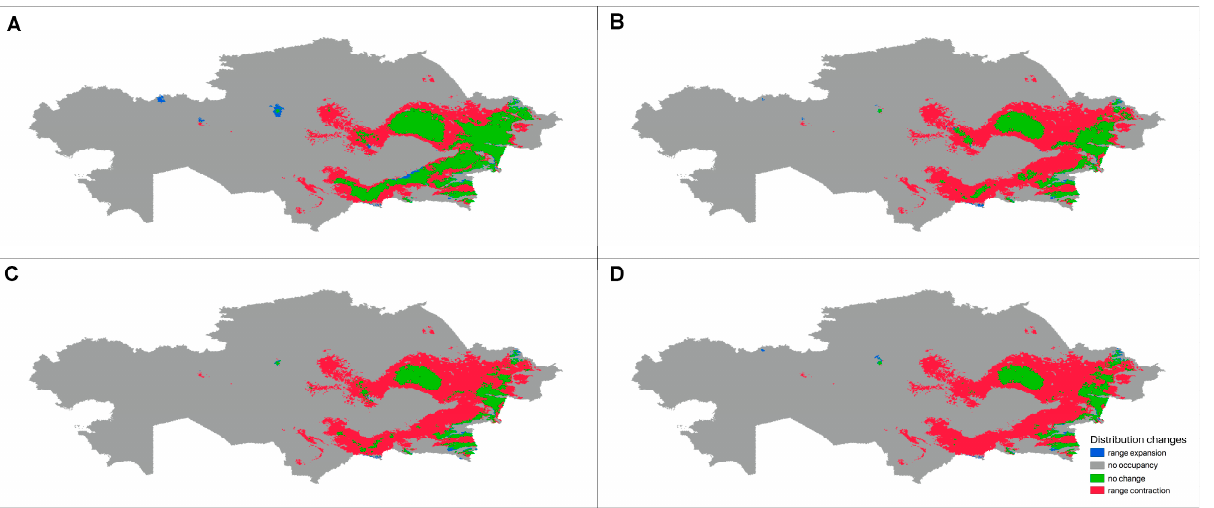
Figure 12. Changes in the distribution of suitable habitats in Kazakhstan for D. salina (Turcz. ex Lindl.) Soó. and four climate change scenarios—spp126 ( A ), spp245 ( B ), spp370 ( C ), and spp585 ( D ).